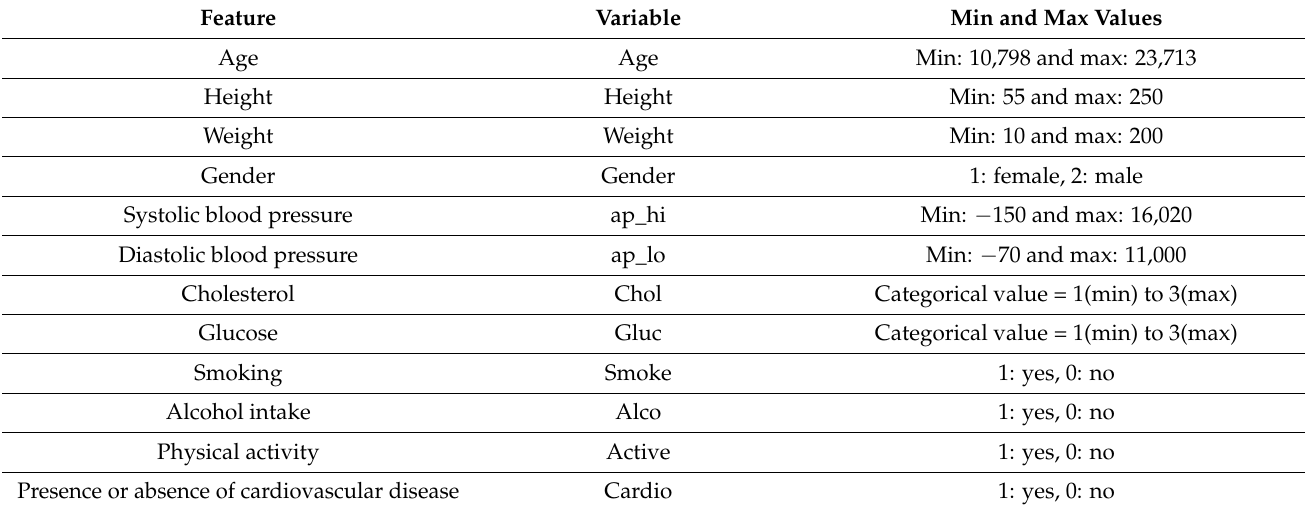
Table 2. Datasets attributes.